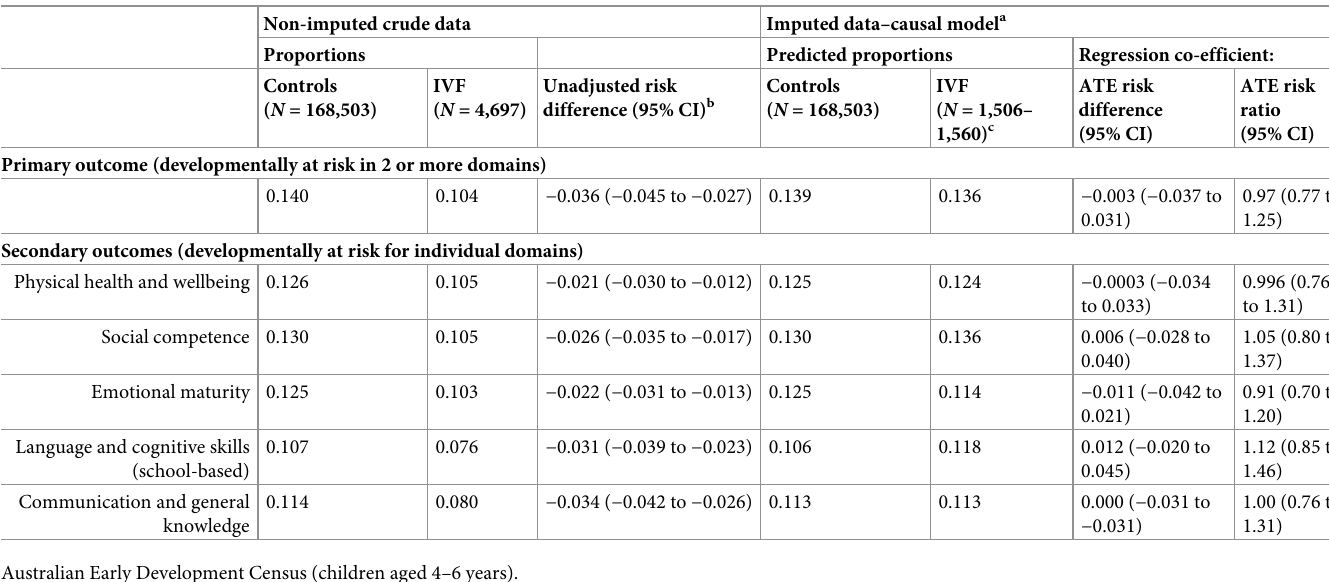
Table 3. Results of final causal